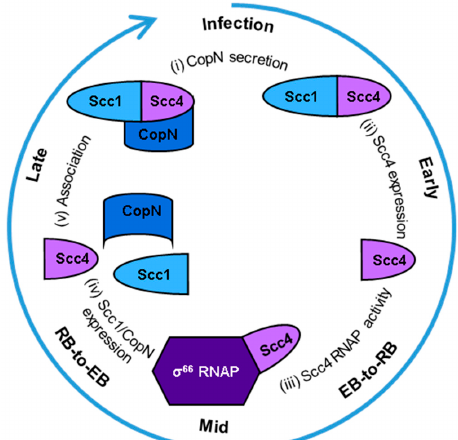
Figure 1. Model of Scc4 ′ s protein-protein interactions during the Chlamydia trachomatis developmental cycle. Starting at the top of the circle and going clockwise: ( i ) Infection is initiated when the T3SS needle on an EB contacts a host cell. The T3SS chaperone complex of Scc4:Scc1 delivers CopN to be secreted into the host’s cytosol, and the complex remains in the bacterial cytosol. ( ii ) Scc4 is expressed in the early stage of the developmental cycle and ( iii ) functions as a σ 66 -RNAP binding protein during the EB-to-RB transition in the middle of the developmental cycle. ( iv ) Scc1 and CopN are expressed during the RB-to-EB transition, late in the cycle. ( v ) Scc4 associates with Scc1, and the complex binds CopN in the EBs. The EBs are released from the host cell to start a new cycle of infection.